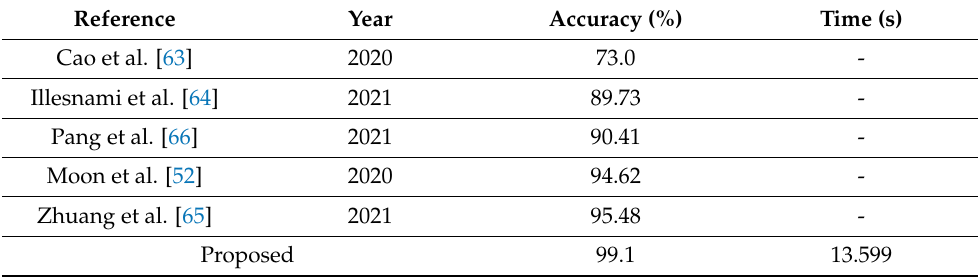
Table 8. Comparison with the state-of-the-art